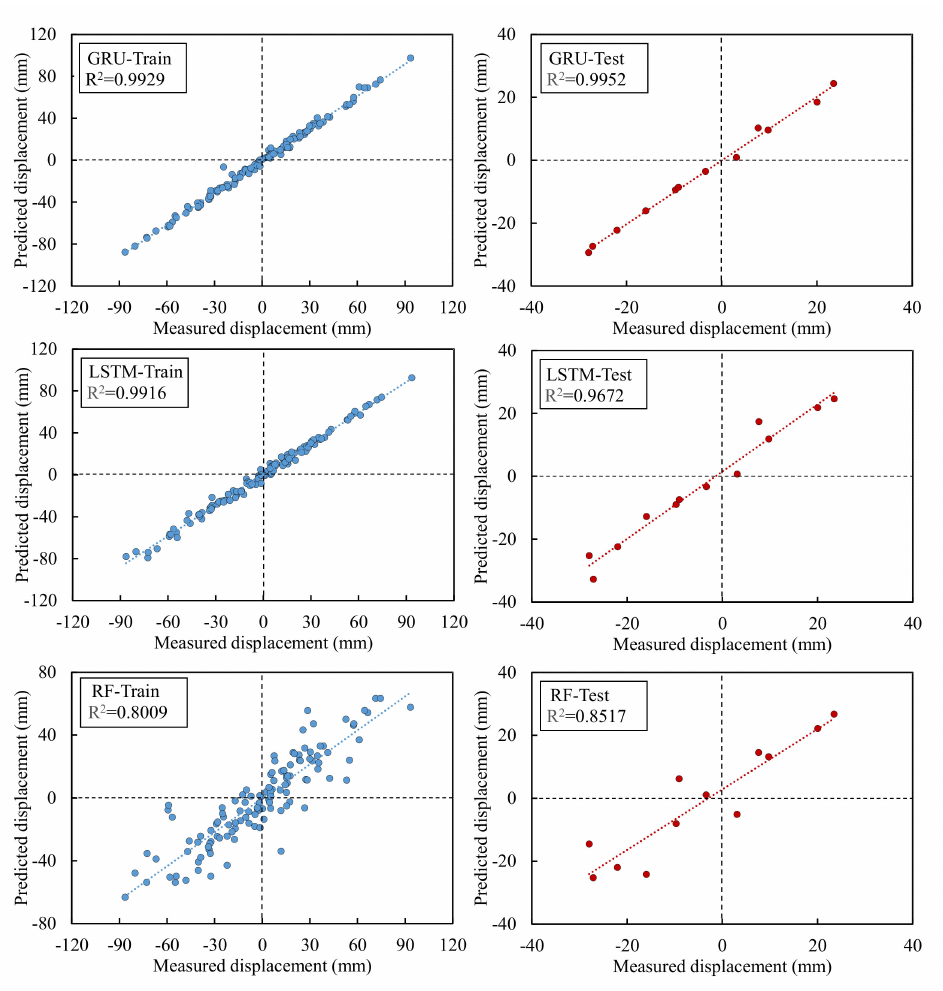
Figure 14. Training and prediction process of each